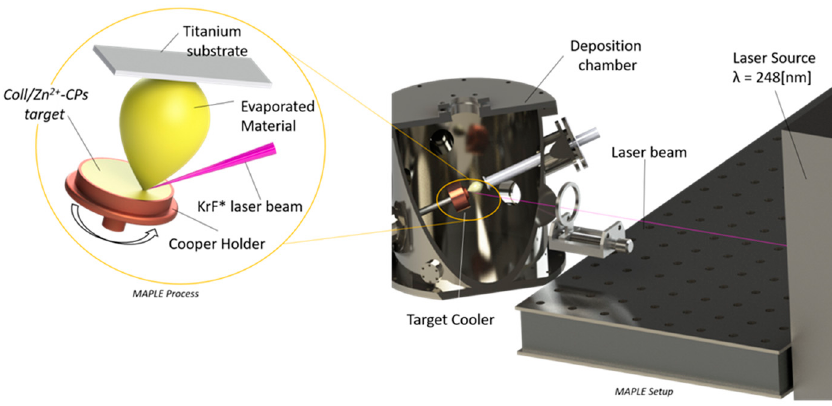
Figure 1. Schematic of matrix-assisted pulsed laser evaporation (MAPLE) set-up.